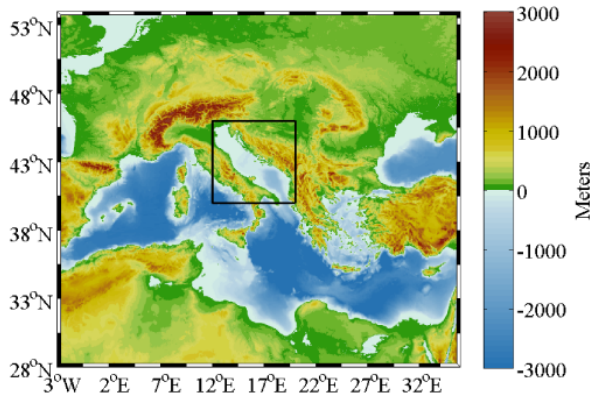
Fig. 1. Orography and bathymetry of the Mediterranean region. The Adriatic Sea area (delimited by a square) extends along the NW-SE direction from 40 ◦ to 46 ◦ North, with length of about 750km, and an average width of about 150km.